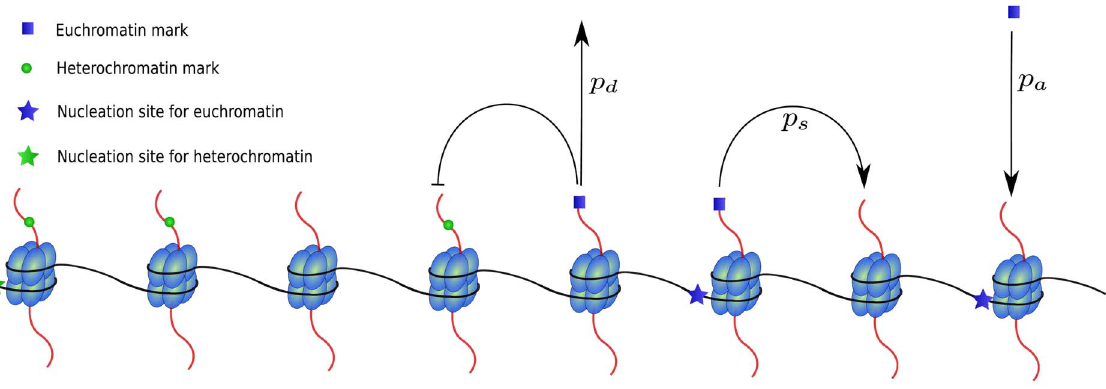
Figure 3. Illustration of the processes nucleation, propagation, competition and deletion in the computational model. Only nucleosomes with nucleation sites can directly be modified with the respective modification with rate p a (probability per histone and time step). Empty nucleosomes with neighboring modified nucleosomes obtain a modification of the same type with rate p s . This parameter can vary for different modification types (euchromatic or heterochromatic). Multiply modified nucleosomes are not allowed in the model with only competing marks and therefore a new mark will not be set if the histone is already modified. Finally, every modified nucleosome looses its modification with rate